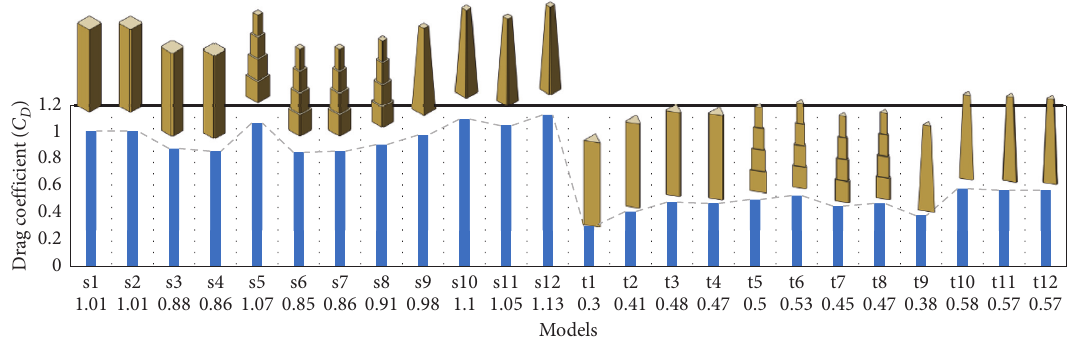
Figure 6: Comparison of models in relation to C